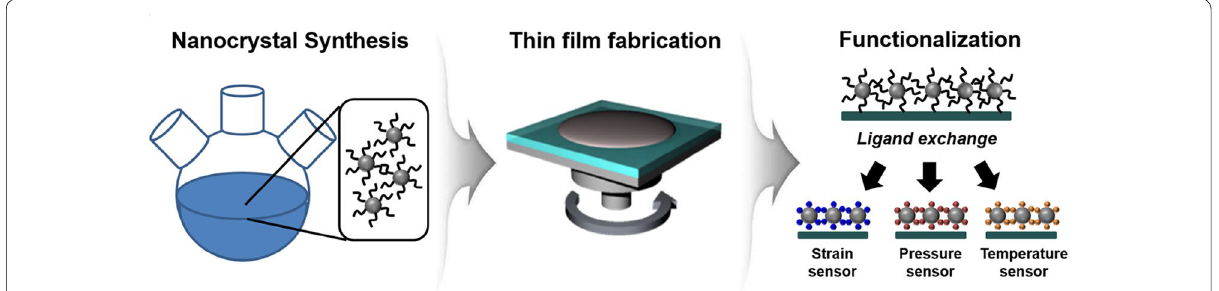
Fig. 1 Schematic of the synthesis, thin film fabrication, and surface ligand exchange processes of